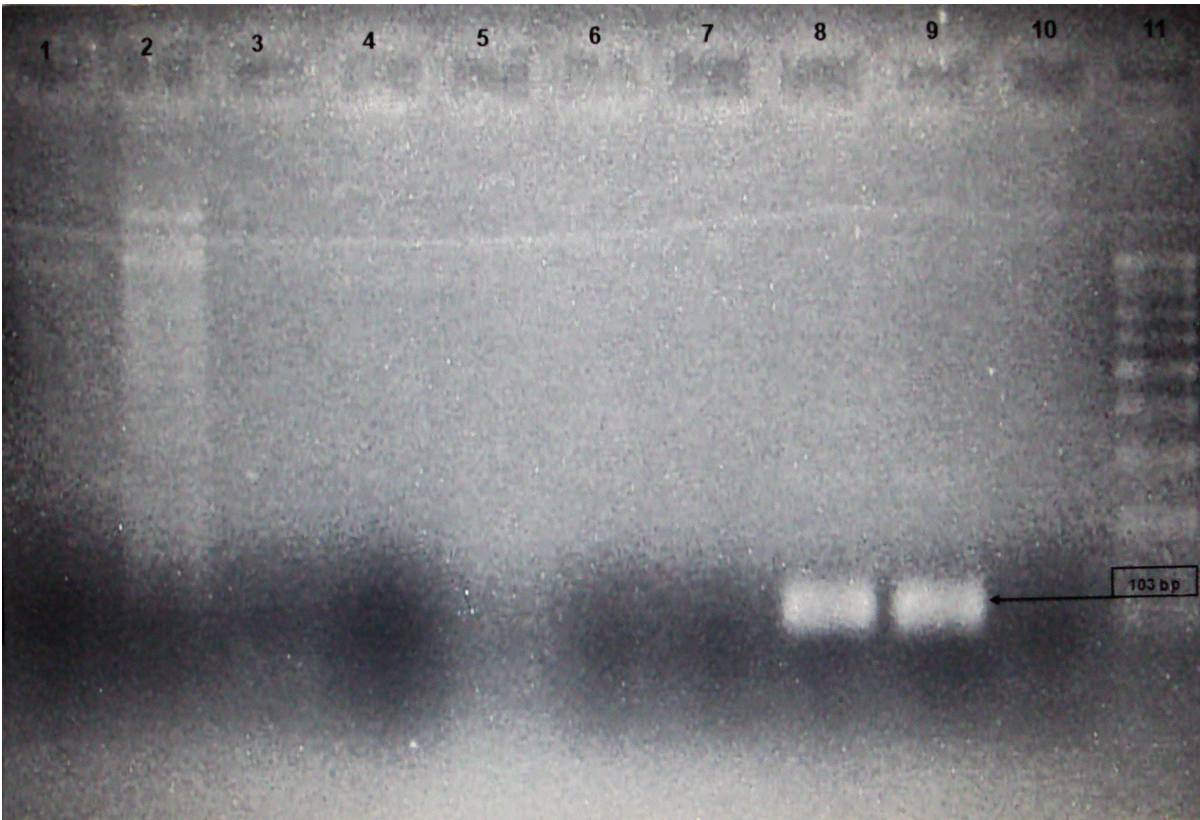
Figure 2. PCR products from samples of oral fluid showing amplification by PCR of L. (V.) braziliensis (lane 8) obtained from a patient with American cutaneous leishmaniasis (amplification of 103 bp). The lanes 1, 3, 4, 5, 6 and 7 identify samples of patients with visceral leishmaniasis; in lane 2, a sample of a healthy control; in lane 9, a positive control; in lane 10, a negative control; lane 11 is the marker that determines the pattern of the molecular size – 103